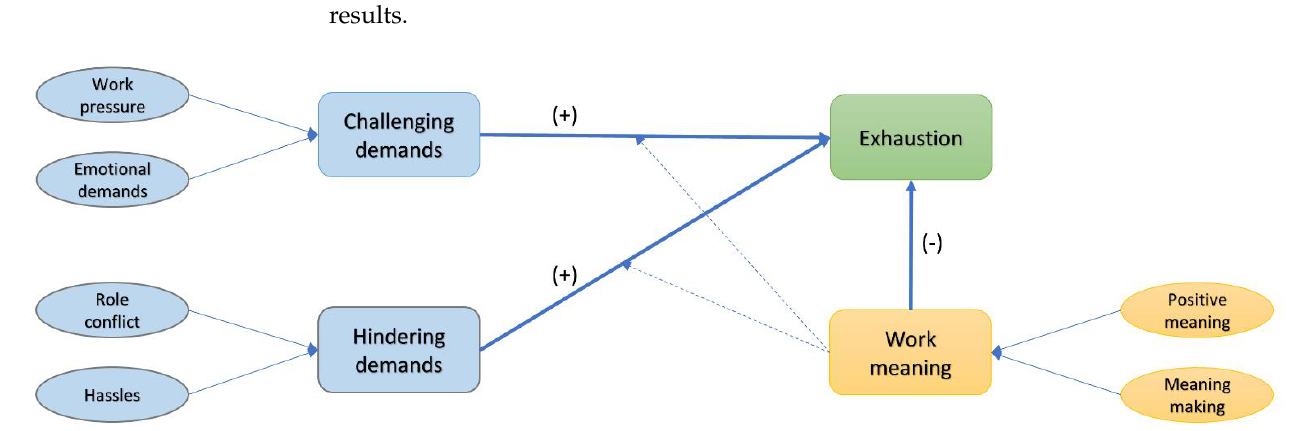
Figure 1. Hypothesized relationships of the research model. Figure 1. - Hypothesized relationships of the research model.